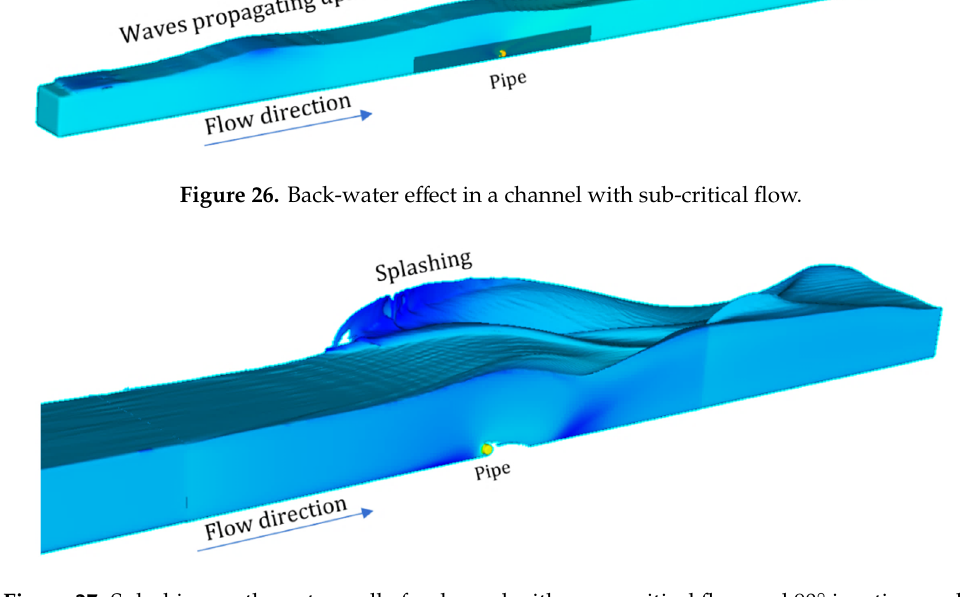
Figure 27. Splashing on the outer wall of a channel with super-critical flow and 90° junction angle.